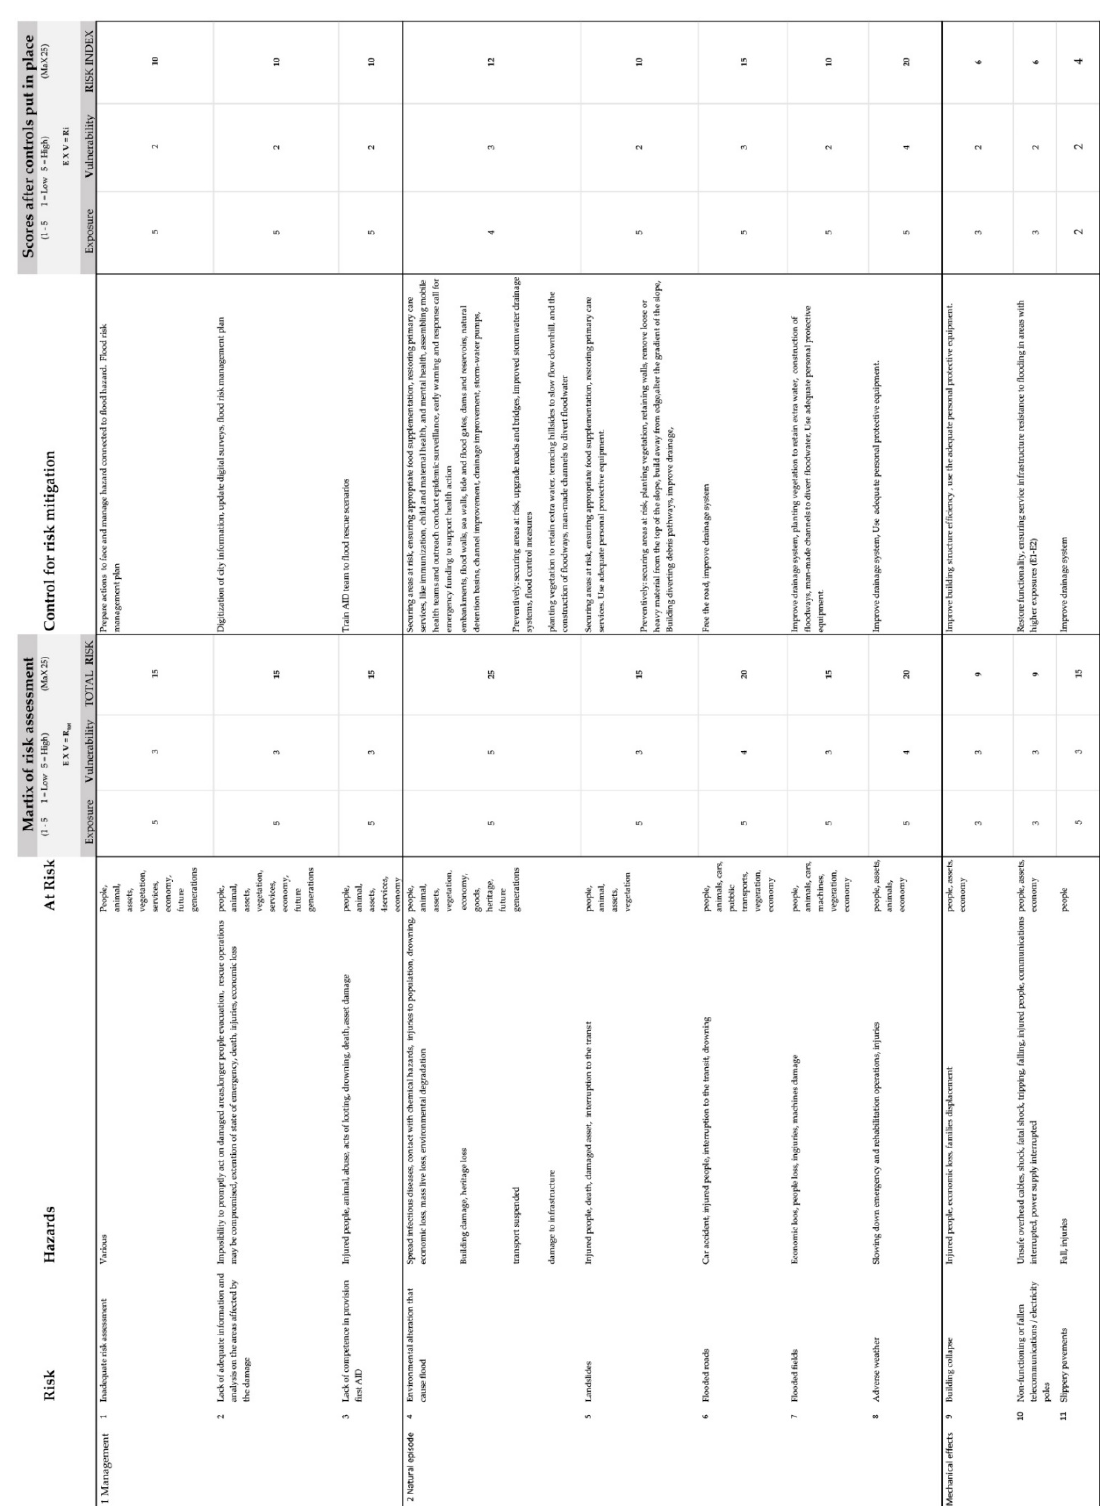
Figure 2. Risk assessment scheme.